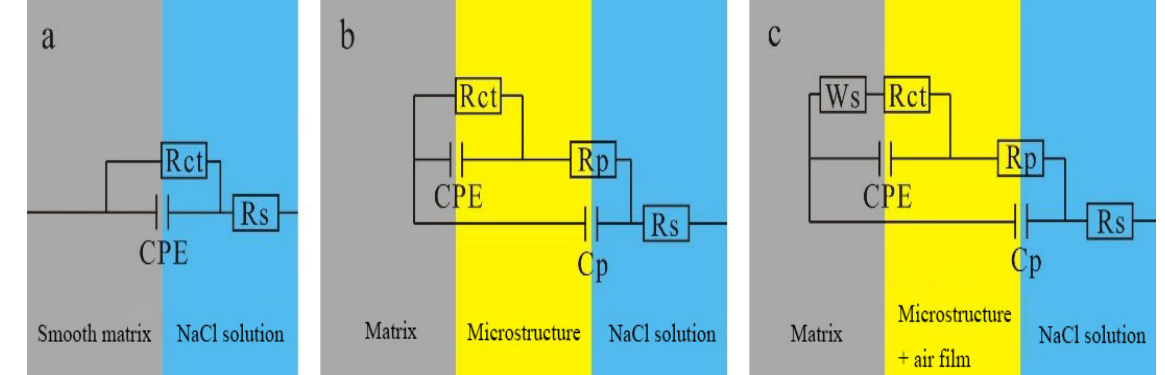
Figure 10. Equivalent circuit models of different samples. ( a ) Polished sample; ( b ) 3D-printed sample; ( c ) 3D-printed + corroded and 3D-printed + modified samples. Table 2. Parameters of equivalent circuit components of different